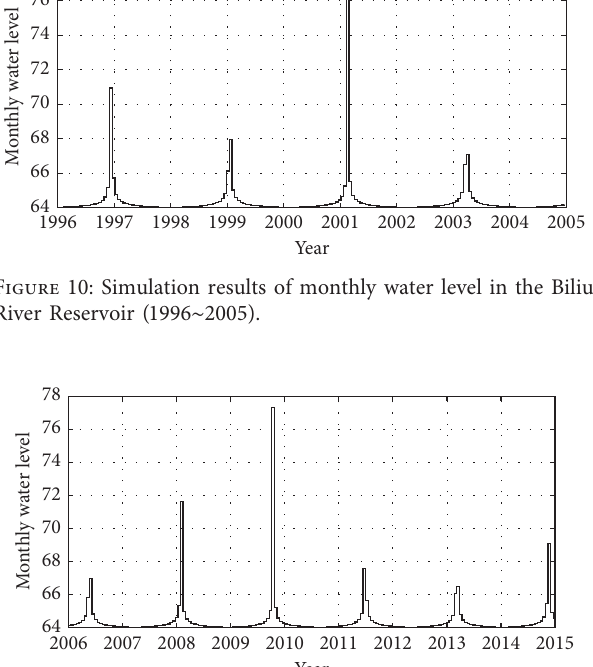
Figure 11: Simulation results of monthly water level in the Biliu River Reservoir (2006 ∼